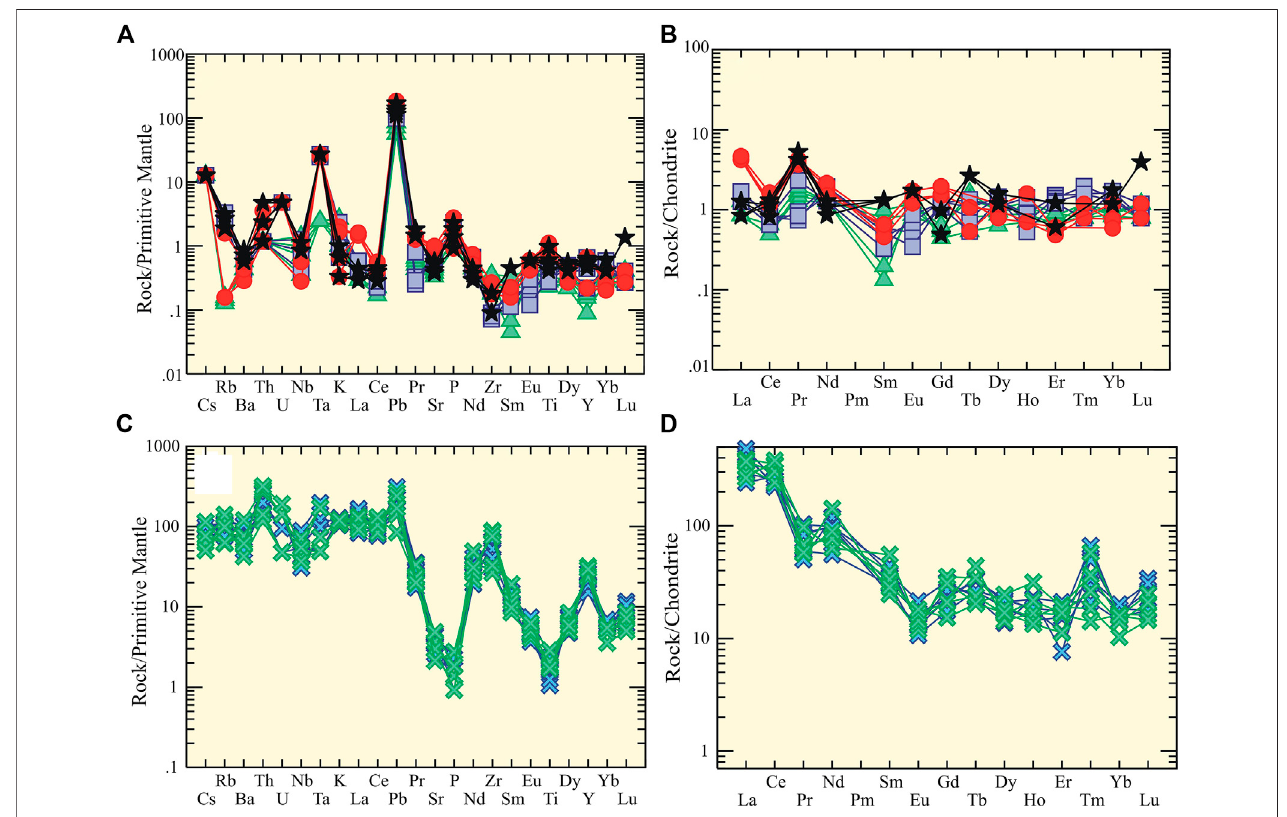
FIGURE 9 | (A) Primitive mantle and (B) chondrite (Cl)-normalized trace element patterns of the examined ultrama fi c rocks after Sun and McDonough (1989); (C) Primitive mantle and (D) chondrite (Cl)-normalized trace element patterns of the examined gneissose rocks after Sun and McDonough (1989).